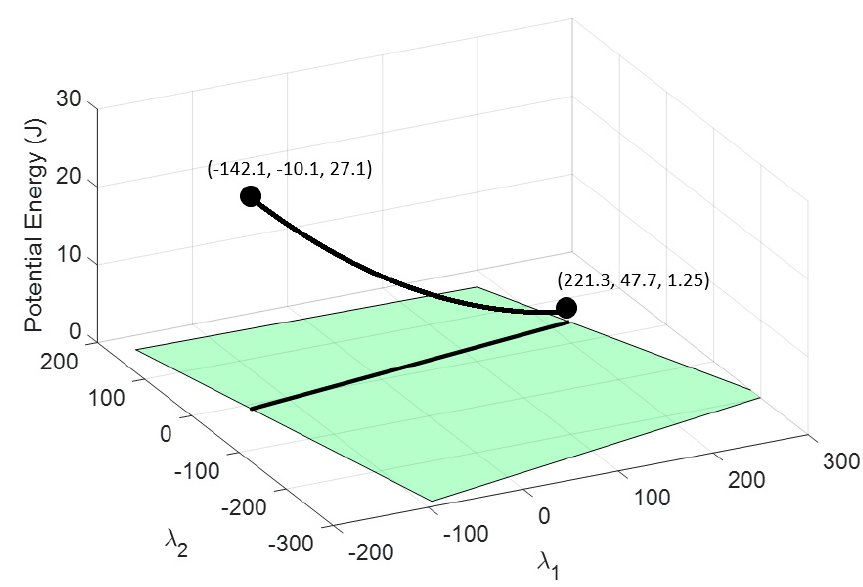
Figure 13. The black 3D curve represents the potential energy stored in cable 1 A by maintaining the condition of setting an elongation in cable 8 of 0.2 m and two grippers hanging from cables 1 and 8.